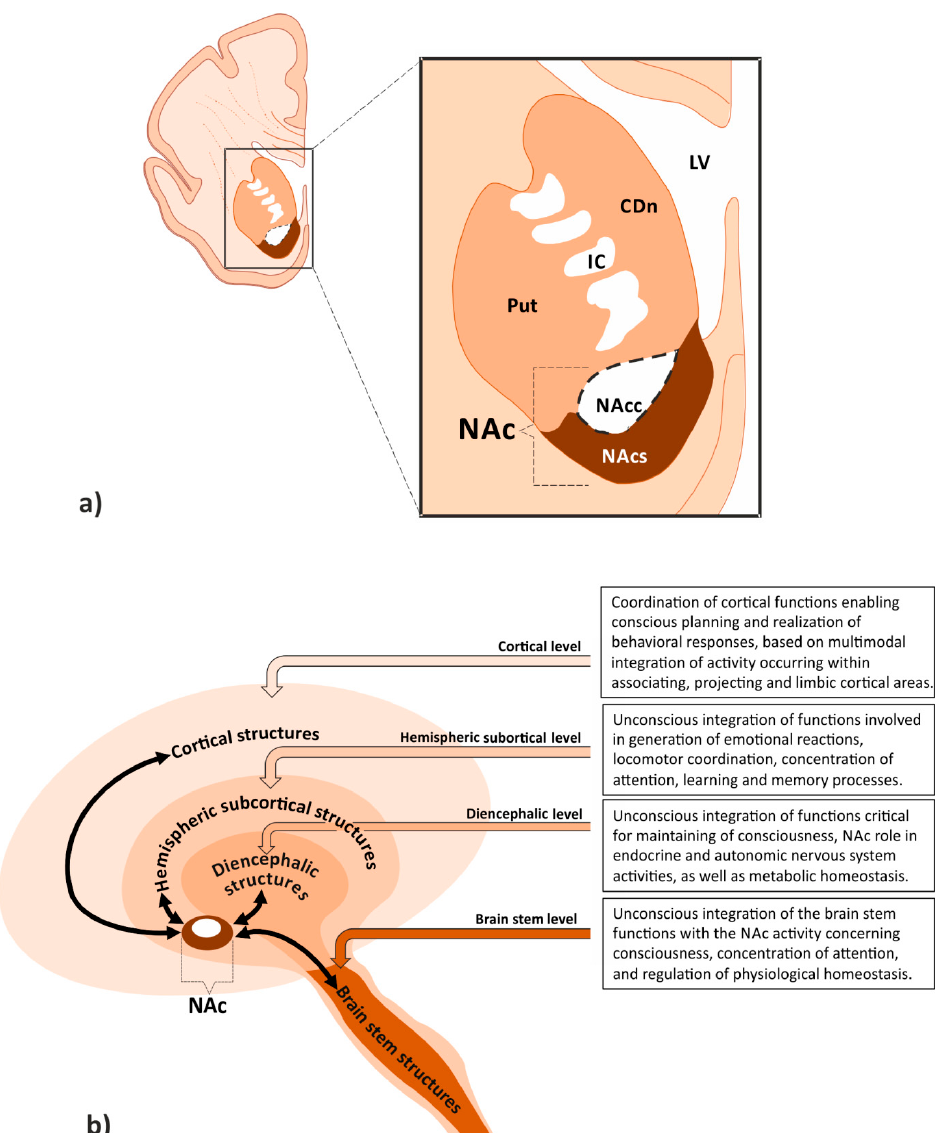
Figure 1. Nucleus accumbens localization and connections . ( a ) Coronal cross-section through the human brain at the level of nucleus accumbens (NAc) occupying the lowest part of striatum, poorly separated from the other areas and divided into a centrally localized core (NAcc) and a peripherally situated shell (NAcs). Medially and upwards, it changes into the caudate nucleus (CDn), and laterally into the putamen (Put). Whereas the dorsal part of the striatum belongs to the locomotor system, its ventral part is considered as a structure of the limbic system. Fibers of the internal capsule (IC) surround NAc superiorly. The localization of NAc on the border of motor and limbic structures enables its integrative and coordinating function upon both systems. ( b ) Due to its localization in the center of the hemisphere, NAc can develop extensive connections with numerous brain areas that can be divided into structural and functional levels (i.e., cortical structures, hemispheric subcortical structures, diencephalic structures, and brain stem structures). This hierarchical arrangement reflects not only the consecutive stages of phylogenetic brain development but also the pattern of cooperation among several functional systems representing various levels of